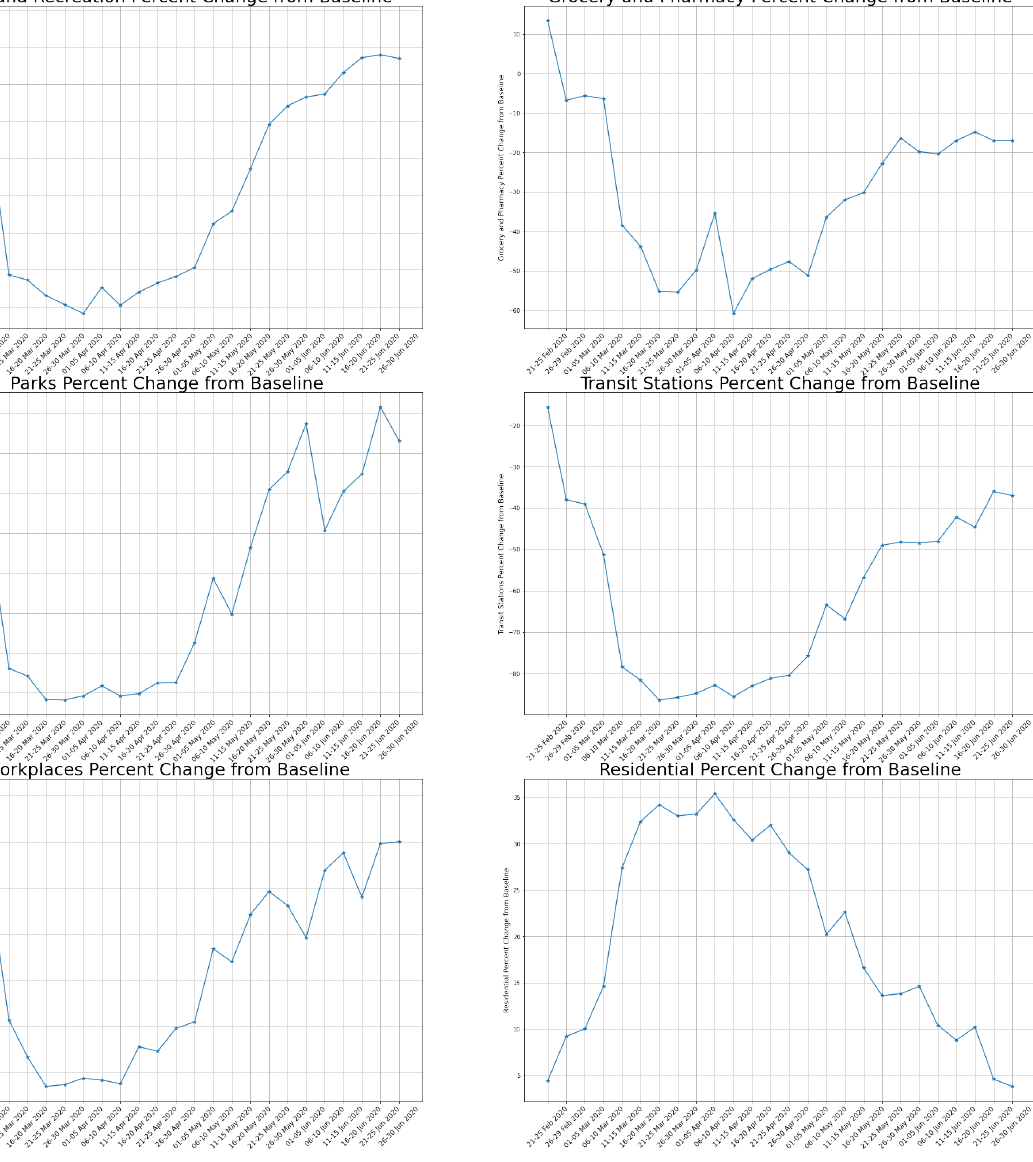
Figure 20. Mobility data for the Lombardy region (from 20 February 2020 to 30 June